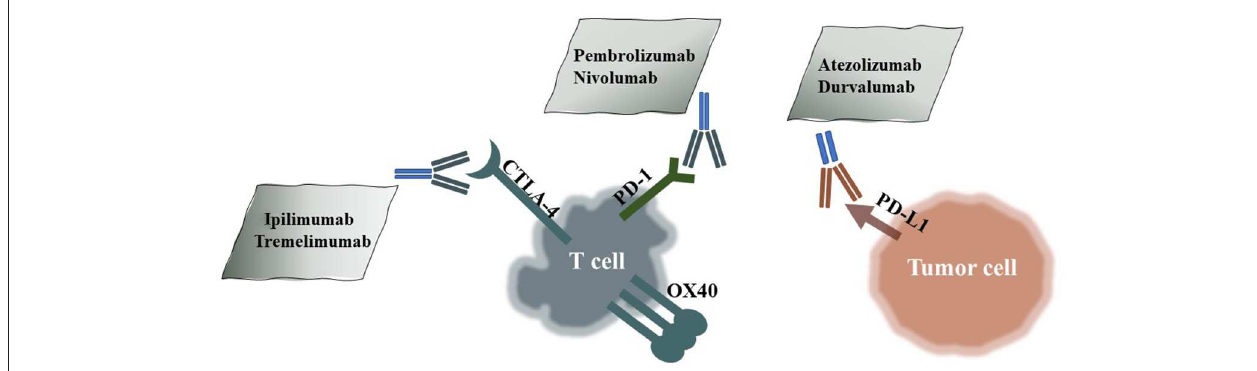
FIGURE 1 | HPD-Related ICIs and Their Targets. Pembrolizumab and nivolumab are PD-1 antibodies; atezolizumab and durvalumab are PD-L1 antibodies; and ipilimumab and tremelimumab are CTLA-4 antibodies.